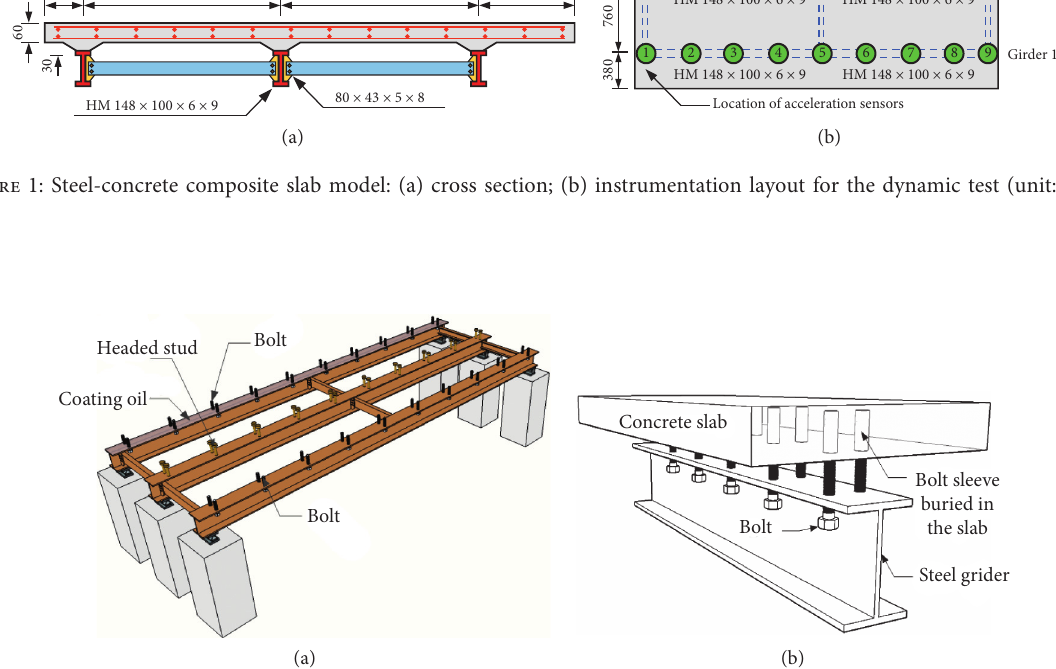
Figure 2: Design of composite slab connection: (a) distribution of the headed shear stud and bolt connections; (b) detailed configuration of the bolted connection along girder 1 and girder